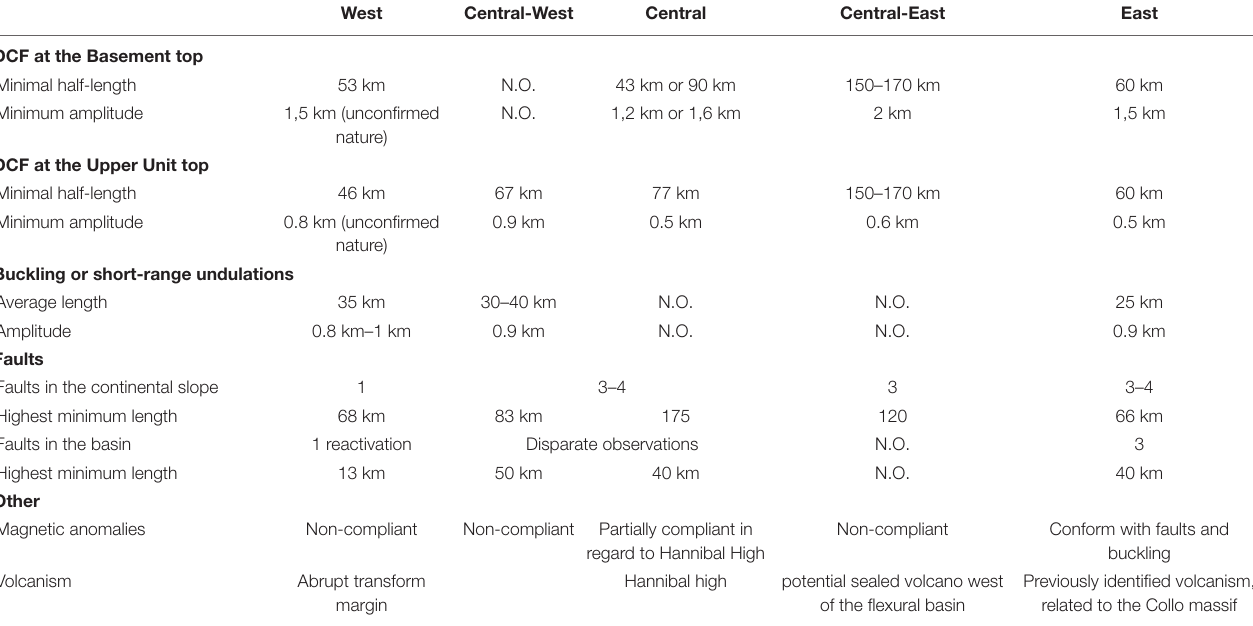
TABLE 2 | Synthesis of the information regarding the deformation of the Algerian margin and basin in relation with the tectonic